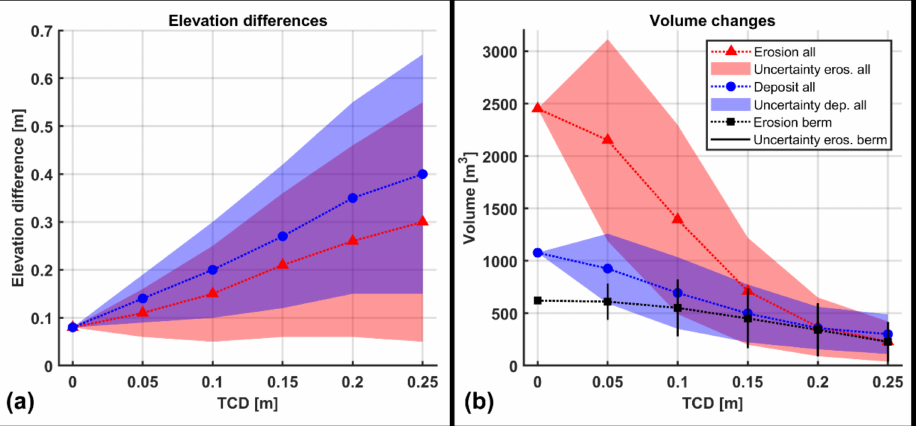
Figure 9. Comparisons of significant erosion and deposit ( a ) average vertical variations for the entire domain and ( b ) volume changes for the entire domain and berm area for the analysed threshold for change detection. The uncertainties related to the assessed variables are also